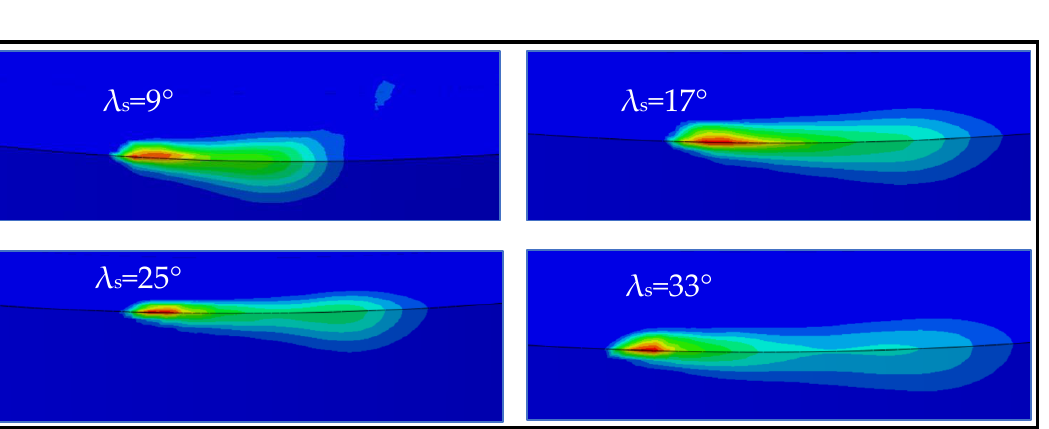
Figure 10. Cutting force variation with di ff erent inclination angles ( V = 100 m / min).